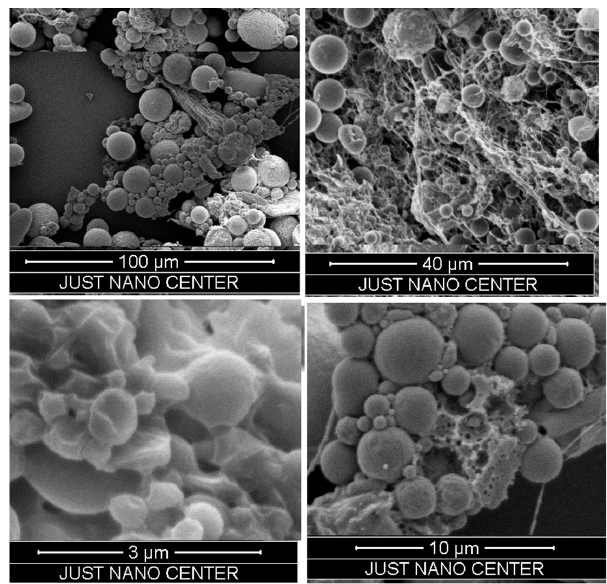
Figure 2. Scanning electron microscope images of LMWC-PLGA nanoparticles showed nanosized spherical particles.